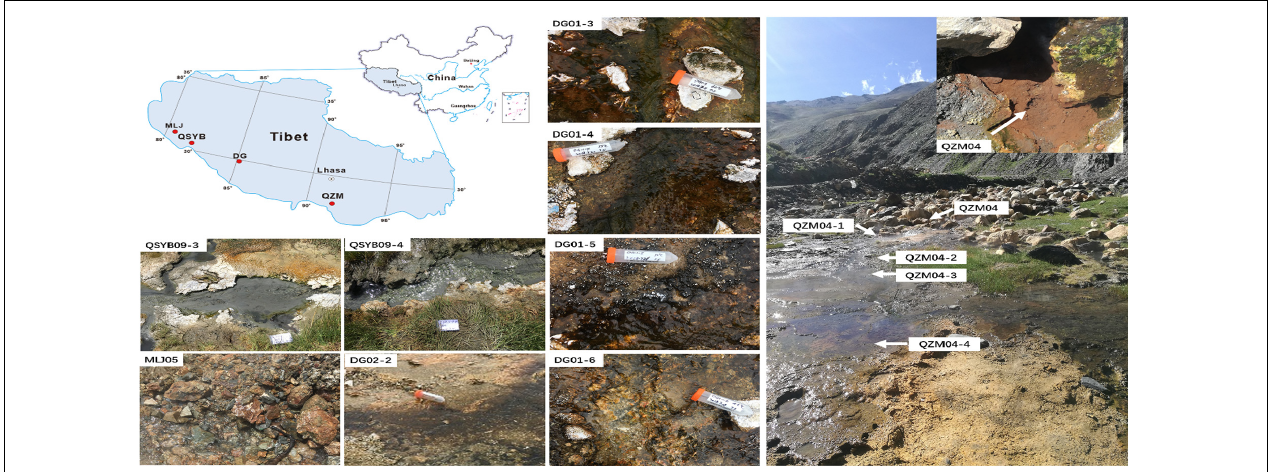
FIGURE 1 | The locations of the studied geothermal zones in the Tibetan Plateau. QSYB, Quseyongba; MLJ, Moluojiang; DG, Daggyai; and QZM, Quzhuomu.